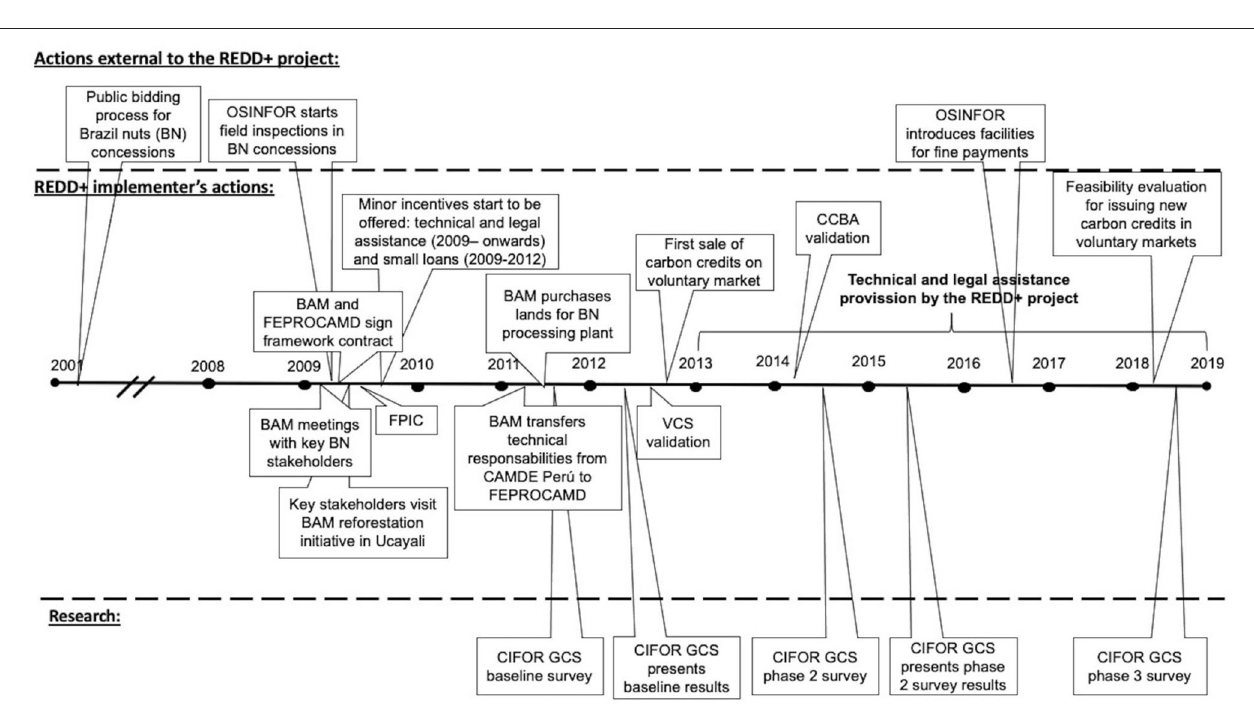
FIGURE 3 | Timeline of Madre de Dios REDD + initiative and related conservation efforts. Garrish et al. (2014), OSINFOR (2018), and own